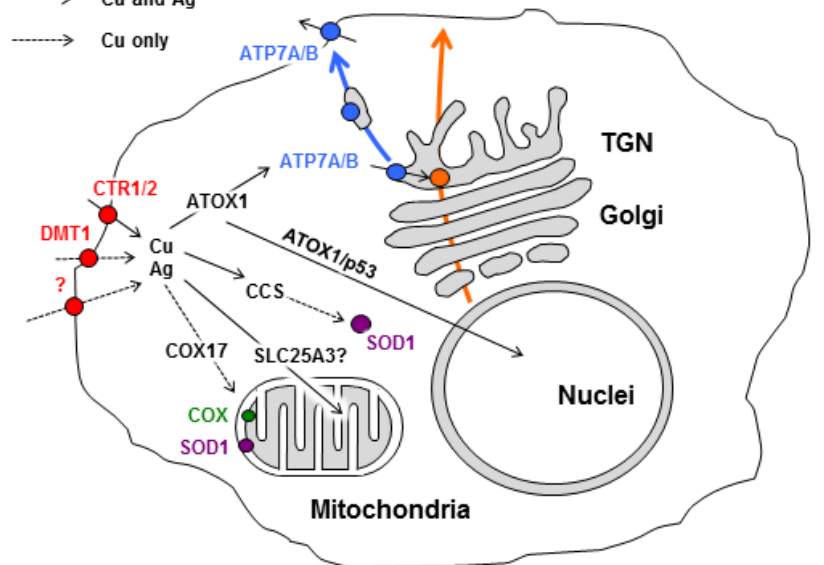
Figure 1. Scheme of copper and silver distribution in a mammalian cell. Copper is taken up via copper transporter 1 (CTR1), divalent metal transporter 1 (DMT1), or the putative transporter (all depicted as red circles). After being imported into the cell, the copper is transferred to chaperone antioxidant protein 1 (ATOX1), copper chaperone (CCS), and cytochrome- c -oxidase (COX17), which ferry it (black arrows) to both copper-transporting ATPase (ATP7A / B, blue) in the Golgi, to Cu, Zn-superoxide dismutase (SOD1, magenta) in the cytosol, and to cytochrome-c-oxidase (COX, green) in the mitochondria. Mitochondrial phosphate carrier protein (SLC25A3) transfers copper into the matrix. In the Golgi, ATP7A / B load Cu on newly synthesized cuproenzymes (orange circle), which transport it along the biosynthetic pathway (orange arrow). A significant increase in intracellular Cu induces the export of ATP7A / B (blue arrow) toward the post-Golgi compartments (TGN) and plasma membrane, where it drives the excretion of excessive Cu from the cell. Silver uses similar copper-transporting routes (solid black arrows). However, several copper-transporting pathways cannot be invaded by silver (dashed black